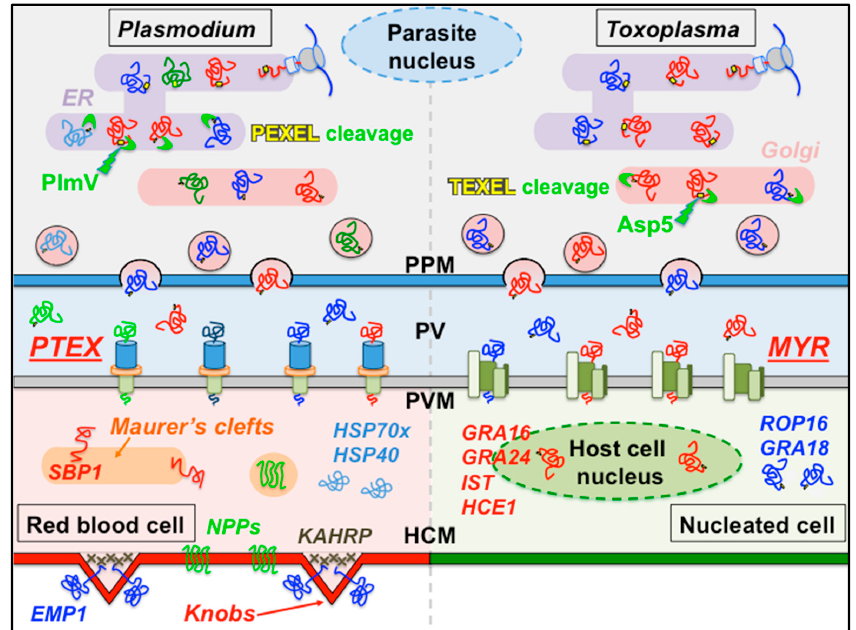
Figure 1. Vacuolar secretion pathways in Plasmodium and Toxoplasma . Effectors and virulence